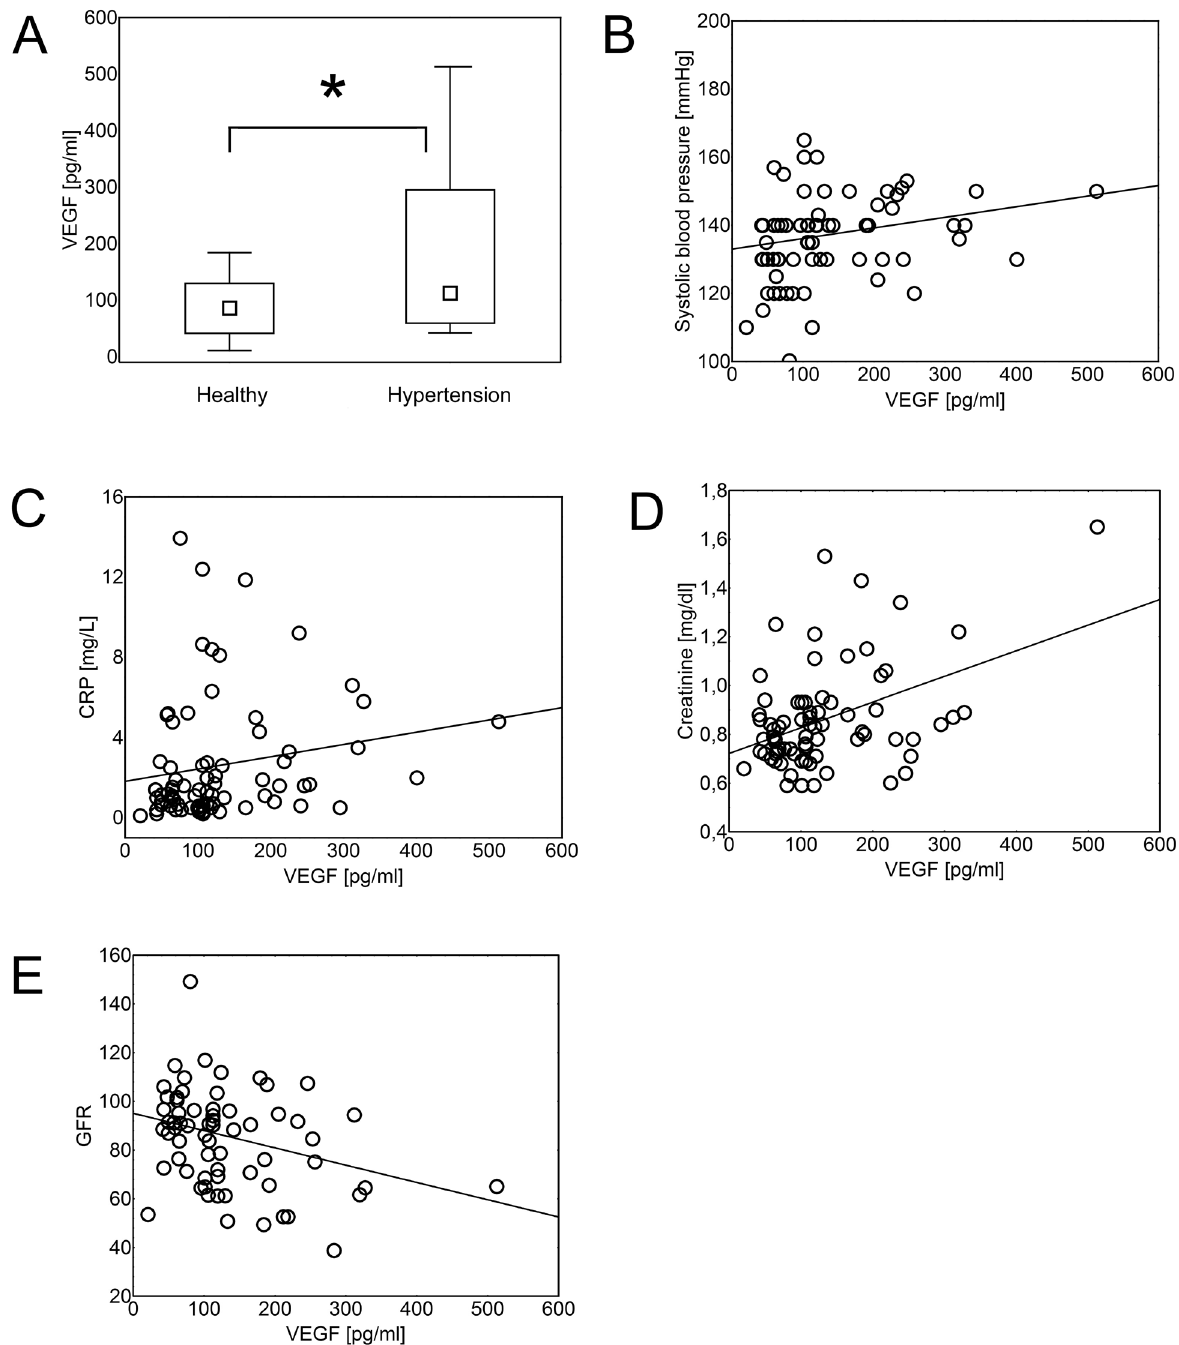
Fig 2. VEGF concentration in hypertension. Hypertension was associated with increased serum levels of VEGF (Mann- Whitney U test; p = 0.02). The data are presented as medians (symbols inside the boxes), 25 – 75% percentiles (boundaries of the boxes) and minimum — maximum (error bars outside the boxes). Statistical significance (p < 0.05) is marked with “ * ” (A). Concentration of VEGF was in positive correlation (Spearman ’ s rank correlation) with systolic blood pressure (B; R = 0,337, p = 3x10 -3 ), CRP (C; R = 0.265, p = 0.02), serum creatinine (D; R = 0.253, p = 0.03) and in negative correlation with glomerular filtration rate (GFR) (E; R = -0.24, p = 0.04). Correlations were calculated for both- hypertensive and healthy individuals together.